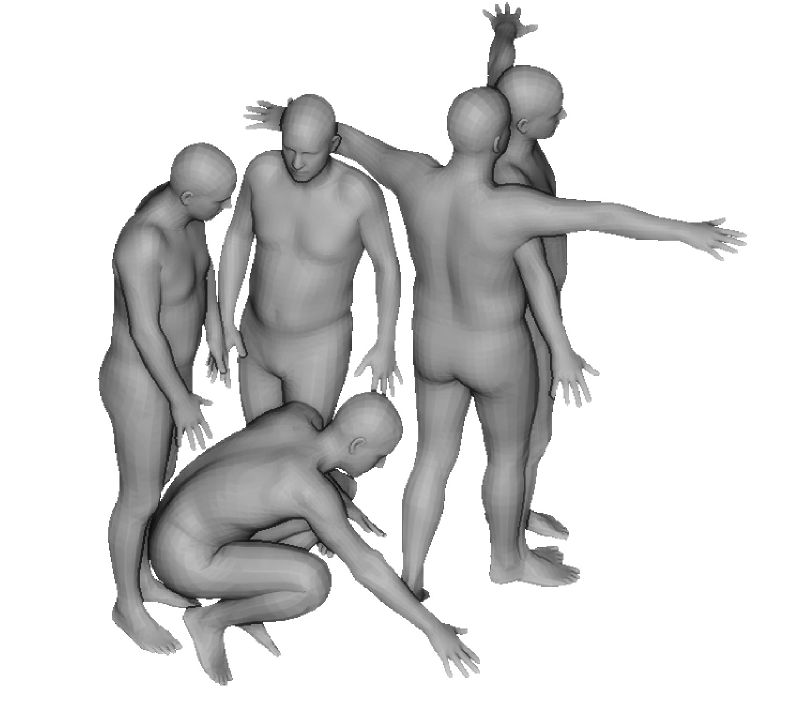
Figure 9. The reconstructed 3D